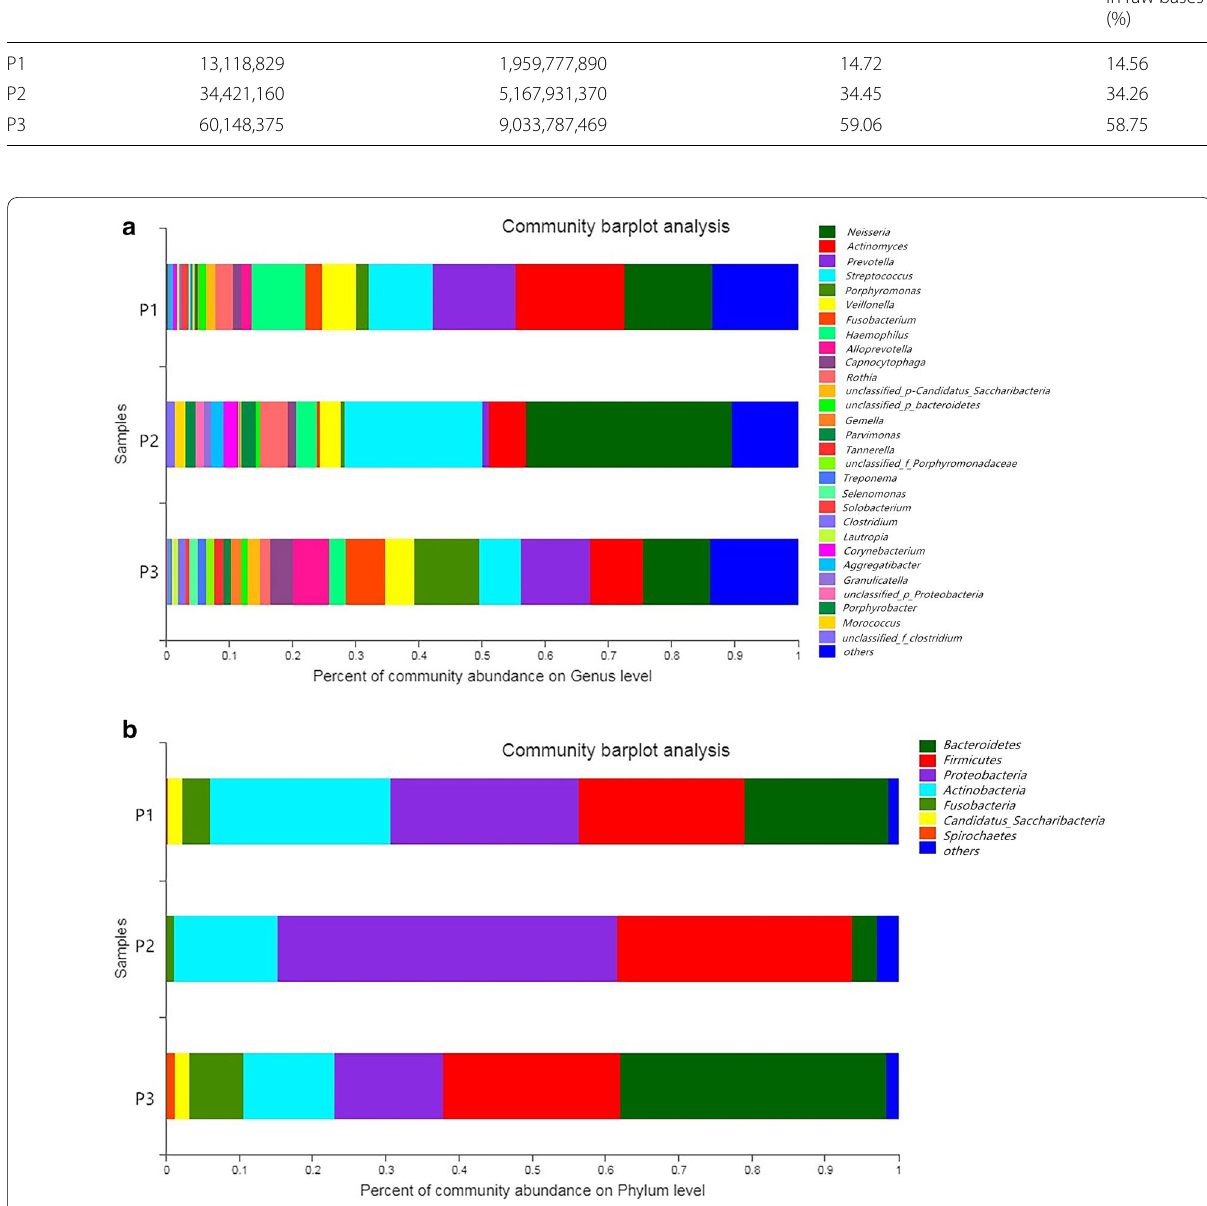
Fig. 3 The three oral samples microbiomes community composition analysis on phylum level and genus